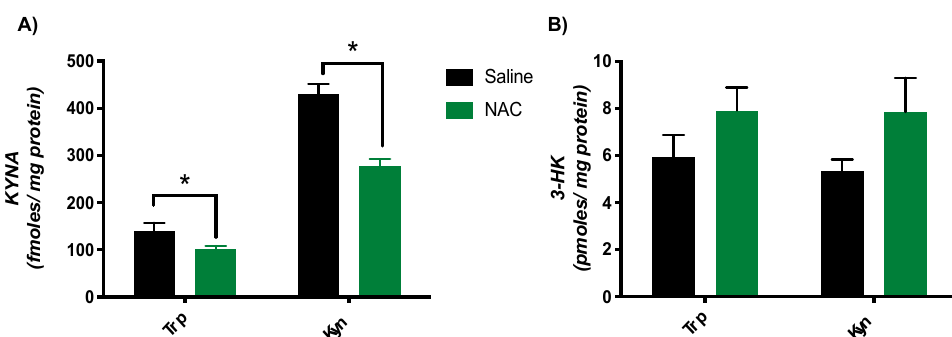
Figure 3. Effect of subchronic NAC treatment on the neosynthesis of KYNA ( A ) and 3-HK ( B ) in brain tissue slices. Tissues were obtained from mice treated i.p. with NAC (100 mg/kg/day) or saline and were then incubated with Trp or Kyn (each 1 mM) in vitro , as described in Materials and Methods. Data are the mean ± SEM ( n = 8 per group); * p < 0.05 vs. saline (pairwise comparisons, Mann–Whitney test).